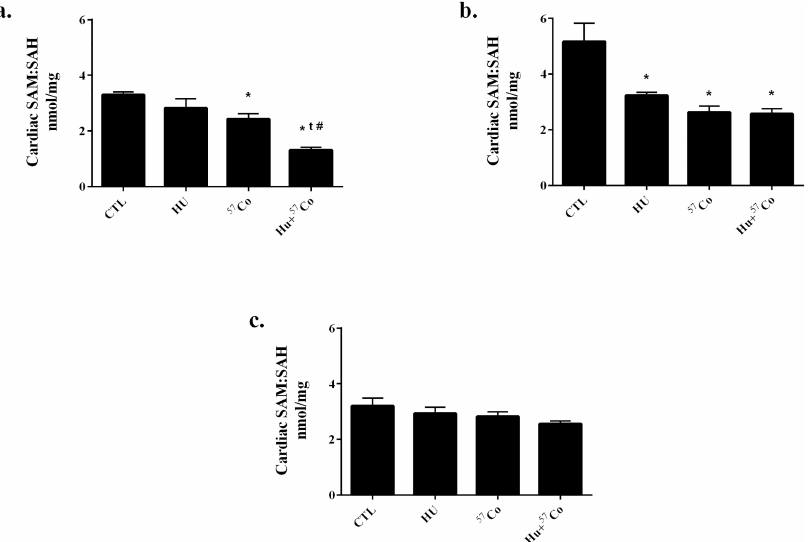
Fig 2. SAM:SAH ratios in mouse heart following HU, γ irradiation or combined HU + γ irradiation. HPLC was utilizedto determineSAM:SAH ratios a.) 7 days, b.) 1 month, or c.) 9 months after a 21 day exposureto HU, γ irradiation( 57 Co: 0.01 cGy/h; 0.04 Gy total), or a combinedHU + γ irradiation. Sample sizes: CTL for all time points, n = 6; HU for 7 day time-point, n = 4; HU for 1 month time-point, n = 5; HU for 9 month time-point, n = 6; 57 Co for 7 day and 9 month time-points, n = 5; 57 Co for 1 month time-point,n = 6; HU + 57 Co for 7 day time-point, n = 6; HU+ 57 Co for 1 and 9 month time-points, n = 5. Values are means ± SEM. * Significantly different than CTL, p < 0.05; t Significantlydifferent than HU, p < 0.05; # Significantly different than 57 Co, p < 0.05; $ Significantlydifferent than HU+ 57 Co, p < 0.05.